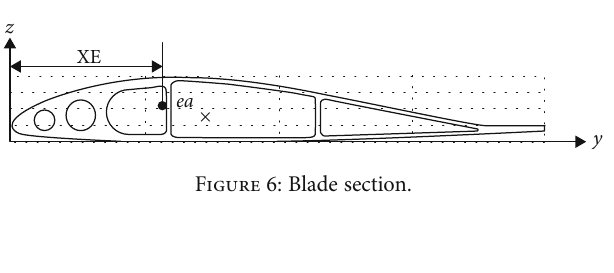
Table 2: Values of parameters of blade section.